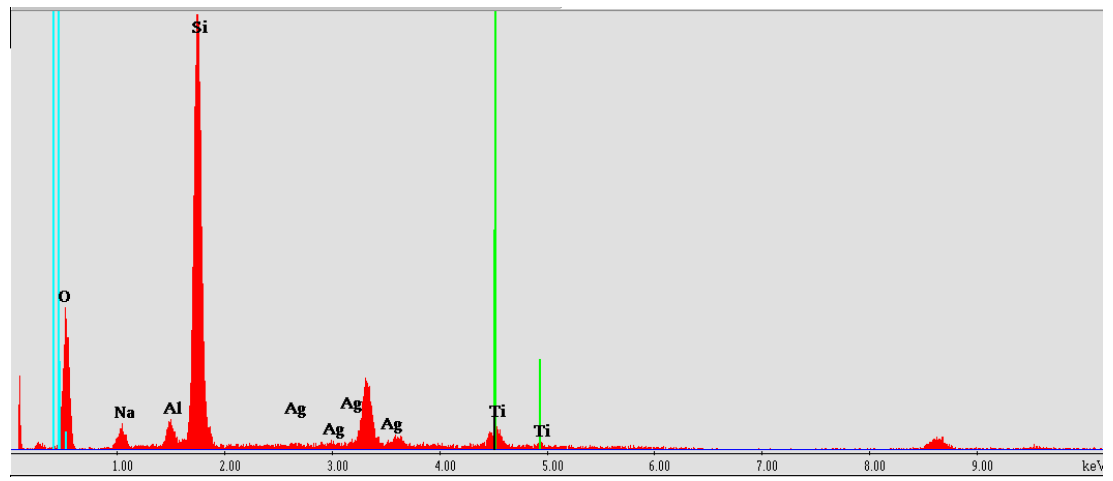
Figure 3. The EDX spectrum of the SilAg precursor, acquired with SEM/EDX system.